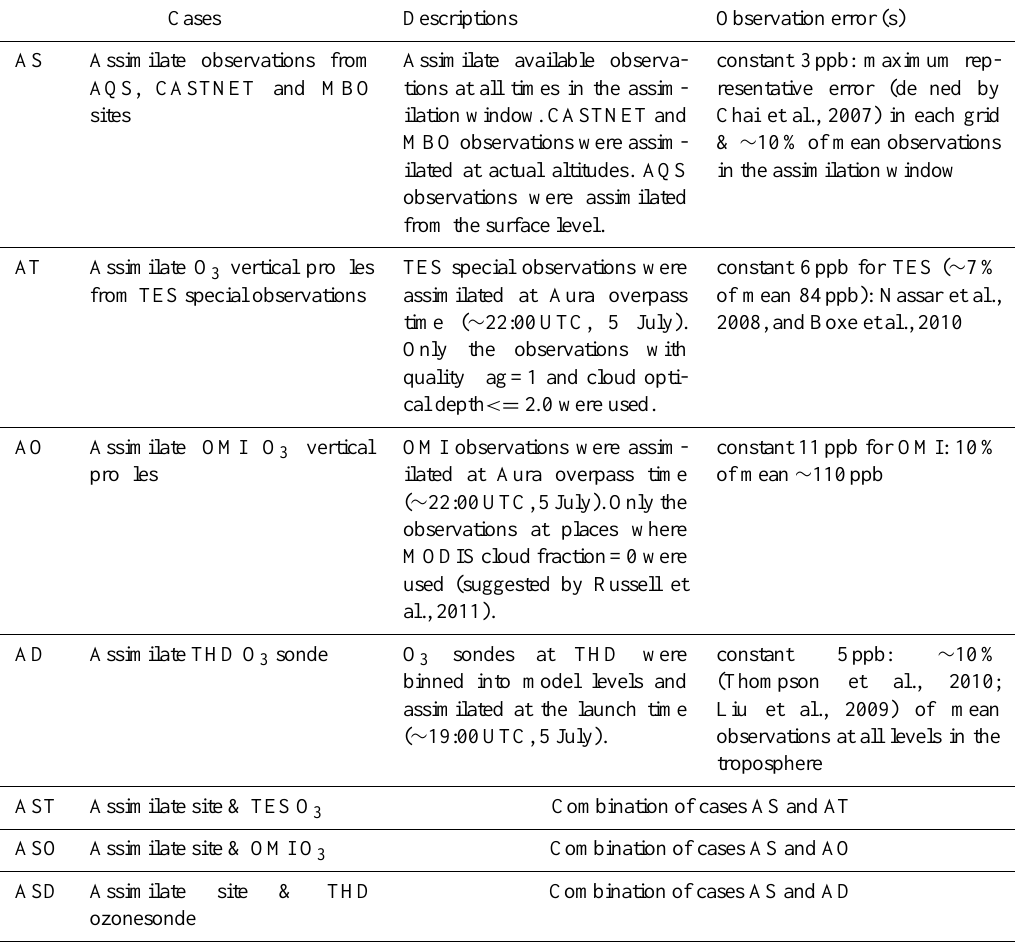
Table 3. Description of 4-D Var data assimilation cases in the 12km model grid ∗